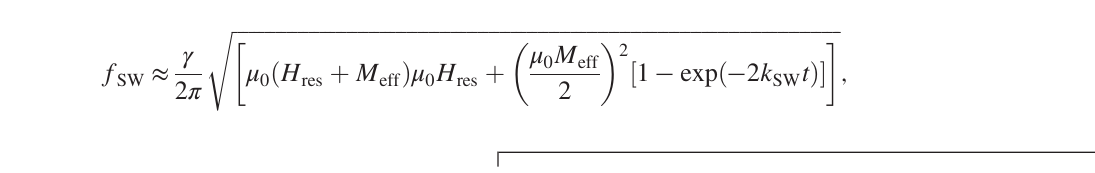
FIG. 7. Schematic illustration of propagating SW spectroscopy on the proximity-engineered structure with Pt = Co ð 0 . 8 nm Þ = Pt spin sinks. When the middle Ni 8 Fe 2 layer is (in-plane) magnet- ≠ 0 ) driven by ized along the positive y direction, the SW ( k SW the microwave excitation propagates along the positive z direc- tion via a collective precession of magnetization M ð z; t Þ (CPWs or MW antennas) with various interspacing of 10 – 25 μ m were patterned on top of the SW track using electron-beam lithography and lift-off of sputtered Cu ð 100 nm Þ = Ti ð 5 nm Þ layers. Two identical CPWs consist of a MW signal line ( 2 μ m wide) and two ground lines ( 1 μ m wide) with an intraseparation of 2 μ m, which preferentially excites or detects the SWs with a wave number k in the SW range of 0 . 9 (cid:2) 0 . 6 μ m − 1 (see Sec. VI of the Supplemental Material [17]).